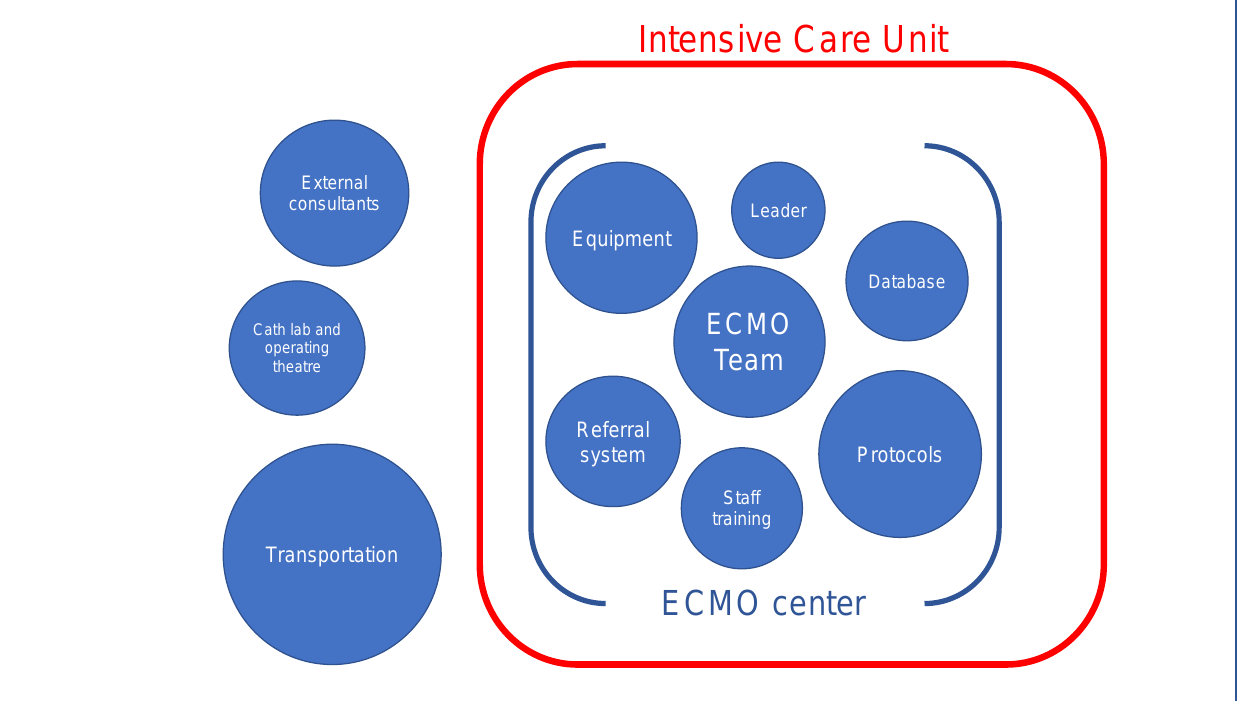
Figure 2. Components of the ICU-based ECMO center.